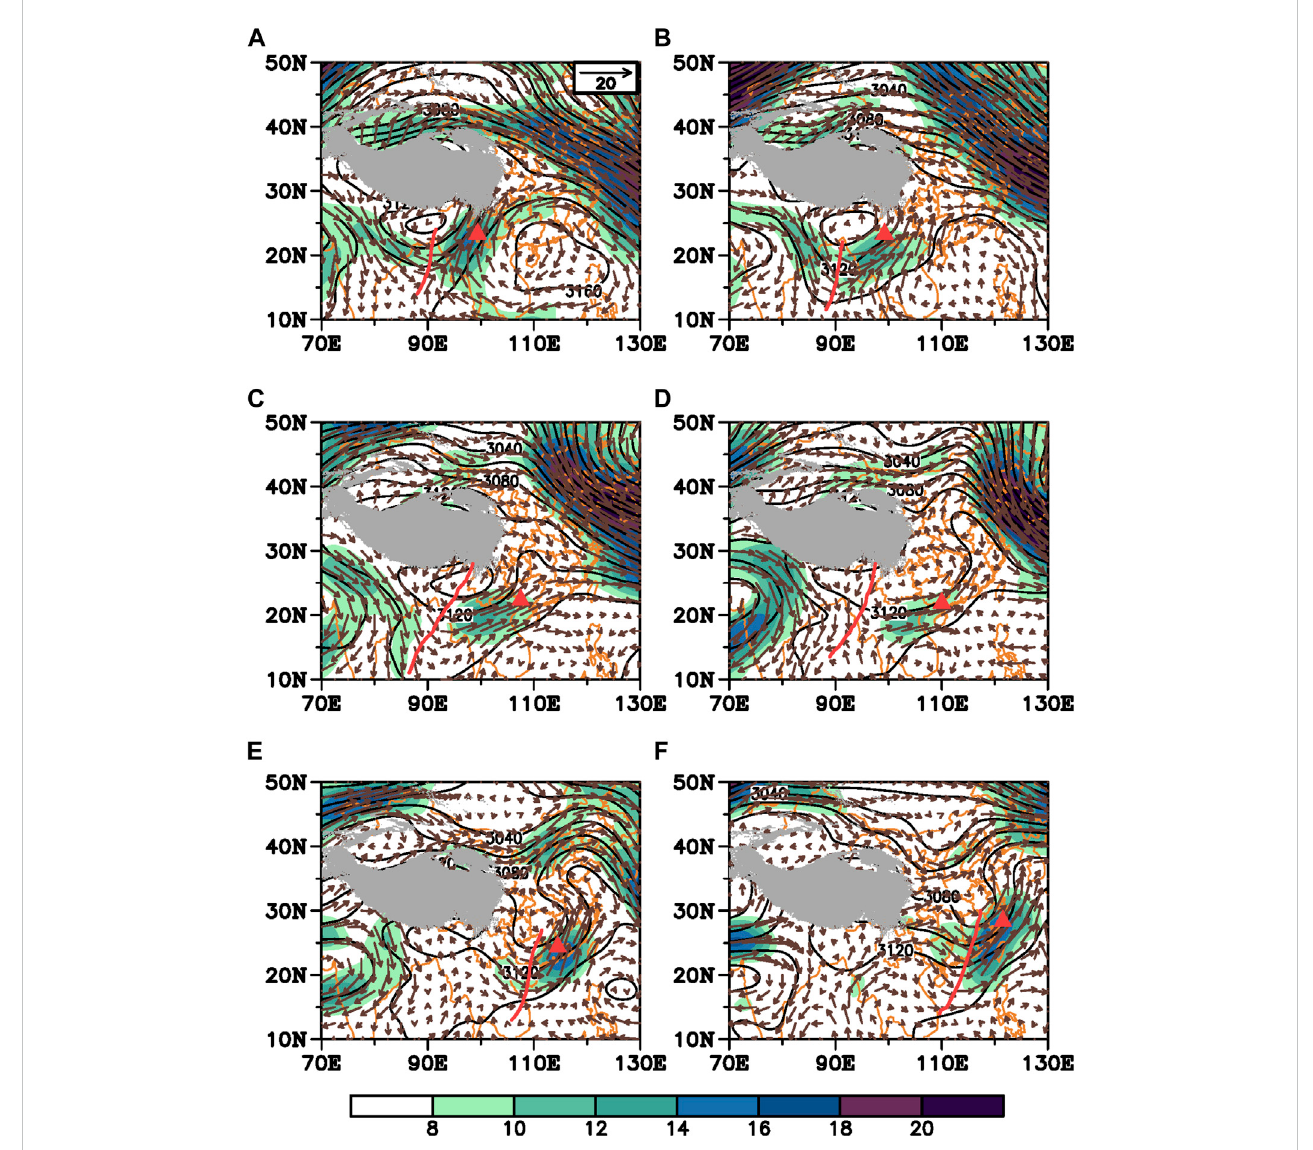
FIGURE 5 Geopotential height (black contours; units: gpm) and wind fi eld (vectors; units: m s − 1 ) at 700 hPa on January (A) 8, (B) 9, (C) 10, (D) 11, (E) 12 and (F) 13 in 2015. Wind speeds greater than 8 m · s − 1 are shaded in color. The red line shows the trough line of the SBT. The red triangle indicates the large-value center of precipitation. The gray shading shows the shape of the Qinghai-Tibetan